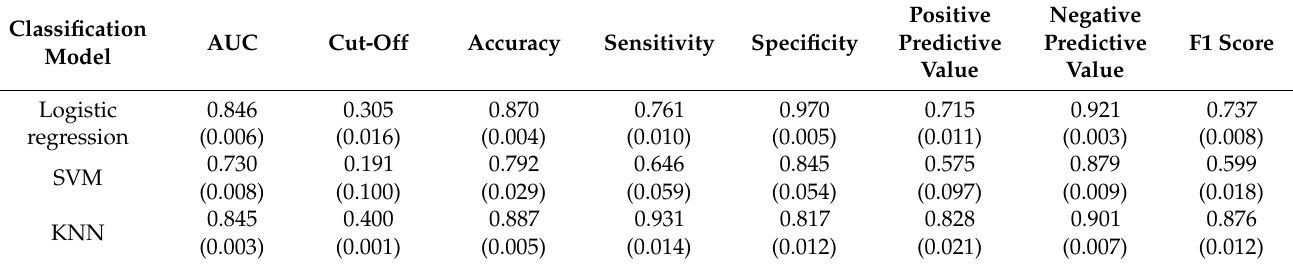
Table 3. Multimodel classification—training cohort *.